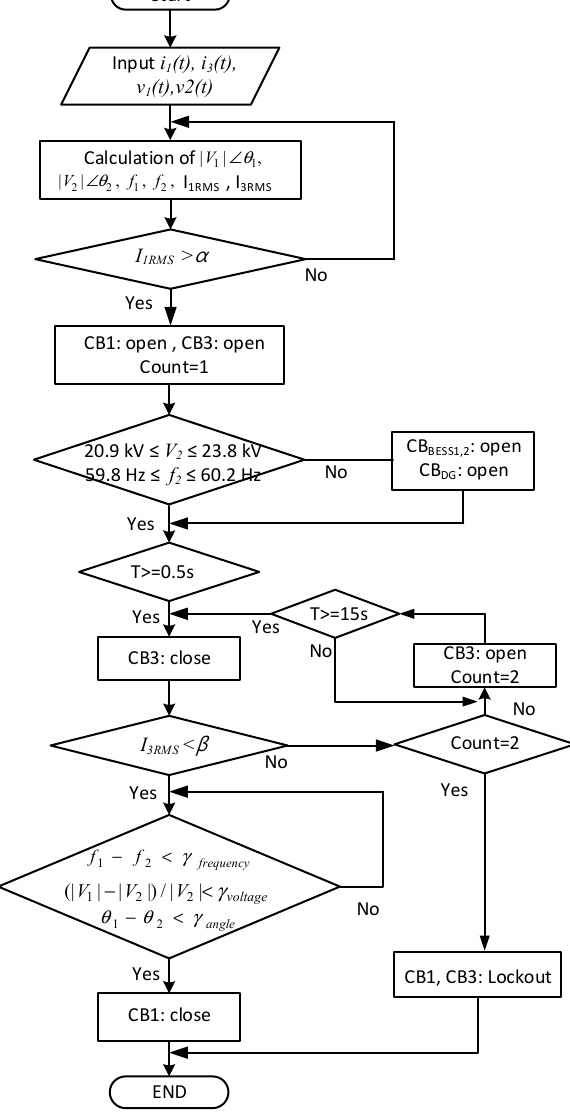
Figure 5. Flowchart of the proposed reclosing method at protective relay 1.